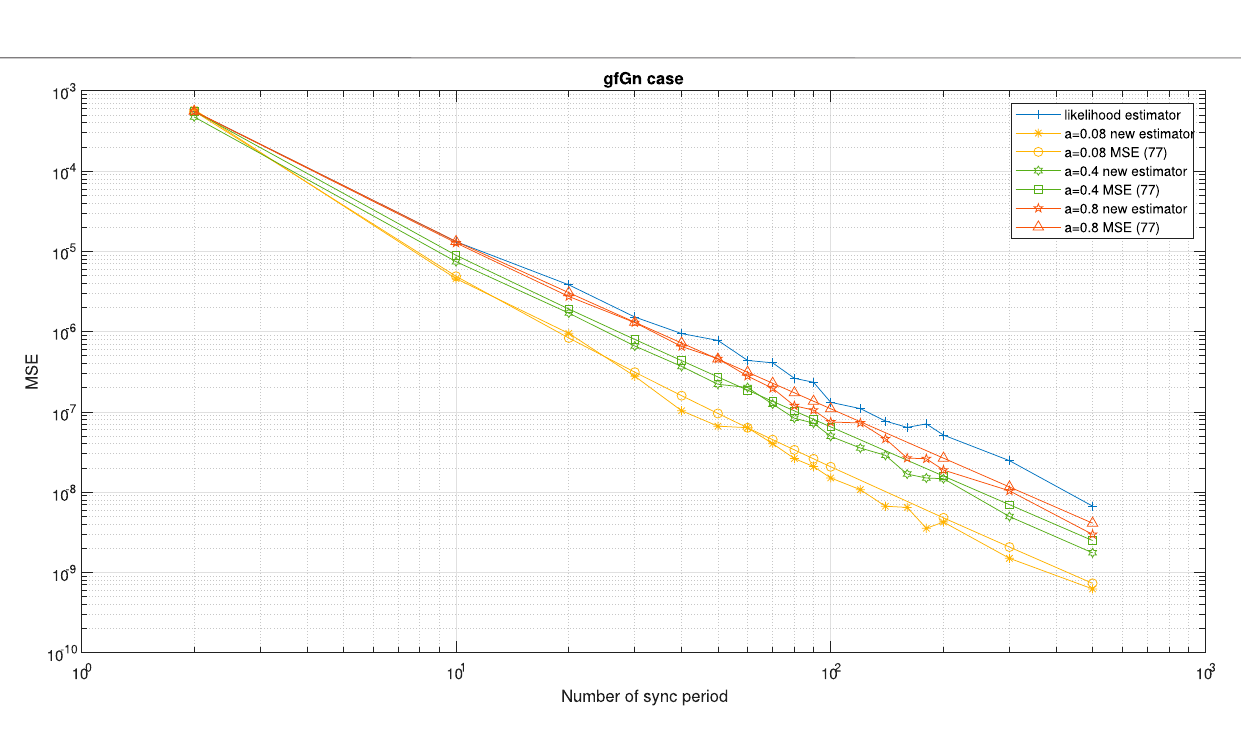
FIGURE10| Performancecomparisonbetweenthenewclockskewestimator Eq.3 withtheclockskewestimator ofNohetal.[34]denoted hereasthelikelihood estimator. In addition, we have the simulated performance results for our new proposed expression for the MSE Eq. 77 for the gfGn case. α (cid:1) 50 ppm , Q (cid:1) 5 ms , T syn (cid:1) (cid:1) σ ω (cid:1) 0 . 1 ms , d (cid:1) 5 ms , d (cid:1) 5.5 ms , H (cid:1) 0.95. The results were obtained for 100 Monte-Carlo trails. 15.6 ms , σ ω ms sm 1 2